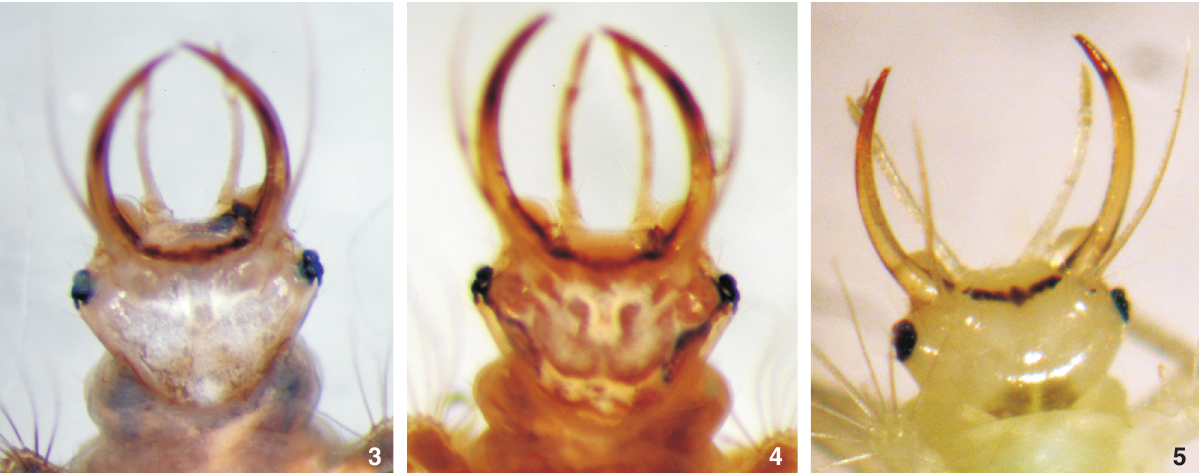
Figuras 3-5. Variações no padrão de manchas tegumentares em larvas de C. caligata : (3) cabeça do terceiro instar somente com mancha intermandibular; (4) cabeça do terceiro instar com mancha intermandibular e subcuticular dorso-lateral; (5) cabeça do segundo instar com mancha intermandibular e epicranial.